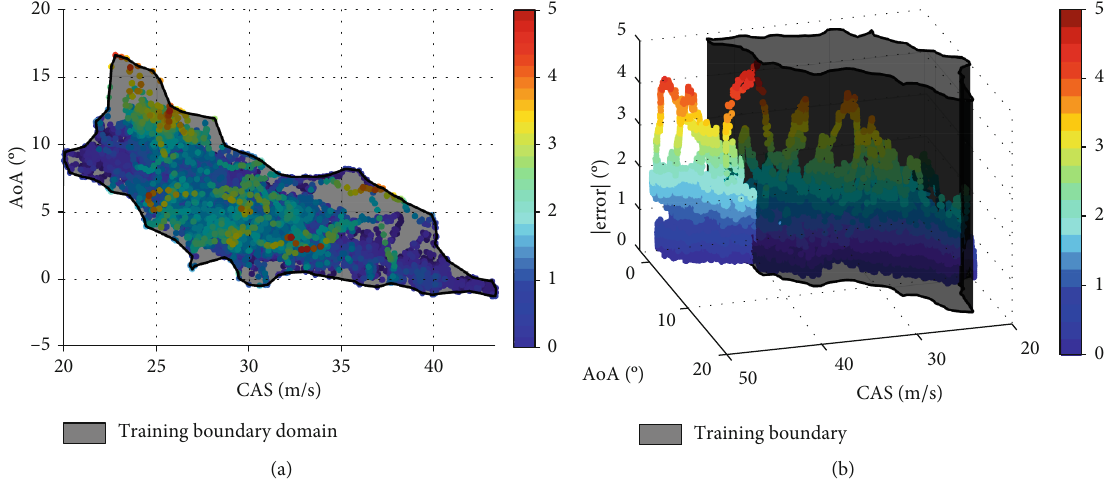
Figure 7: AoA estimation errors in the plane AoA-CAS for the (a) training and (b) validation